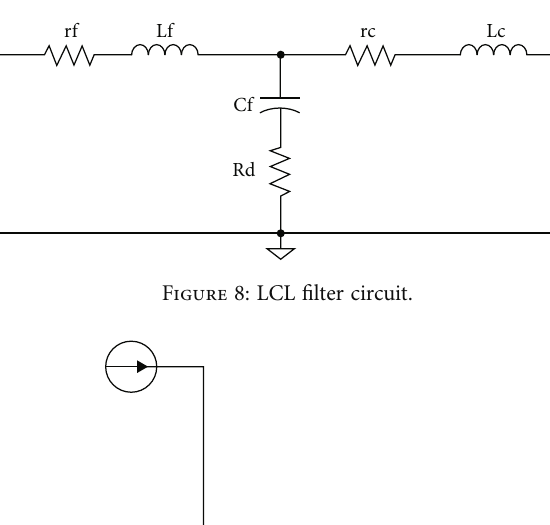
Figure 7: Current controller (a) quadrature axis voltage reference, (b) direct axis voltage reference.